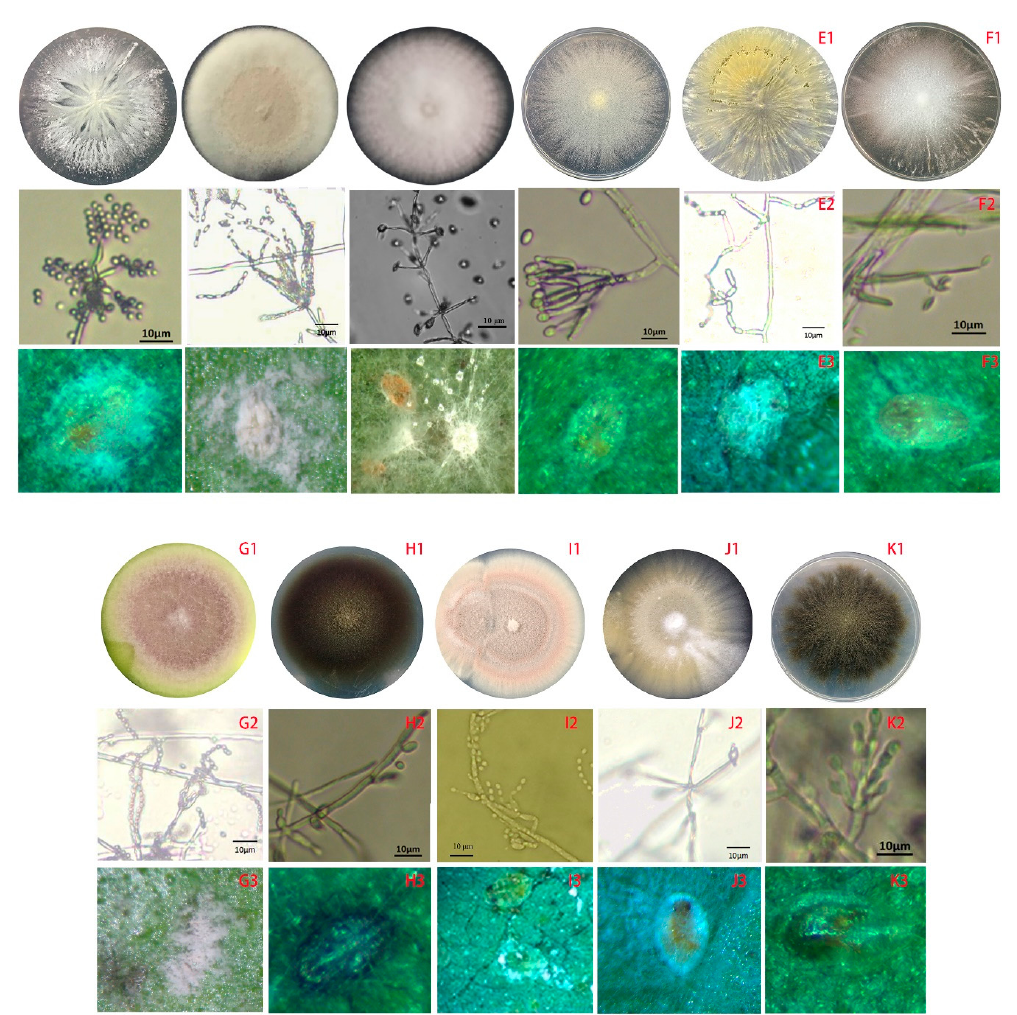
Figure 5. The feature profiles of entomopathogenic fungi (EFs) and the symptoms of whiteflies infected by different isolates. A , BbGD07 of Beauveria bassiana ; B , IfFJ05 of Isaria fumosorosea ; C , LpGD62 of Lecanicillium psalliotae ; D , ClspGX21G03 of Clonostachys sp.; E , MaFJ07 of Metarhizium anisopliae ; F , NmGX2905 of Nectria mauritiicola ; G , PamGD01 of Metarhizium marquandii ; H , PhvGX77A02 of Phialophora verrucosa ; I , PlHN01 of Purpureocillium lilacinum ; J , PocGD43 of Pochonia chlamydosporia ; K , SbGX7705 of Scopulariopsis brumptii ; 1, colony; 2, conidial structure; 3, symptoms of whiteflies. Bar = 10 µ